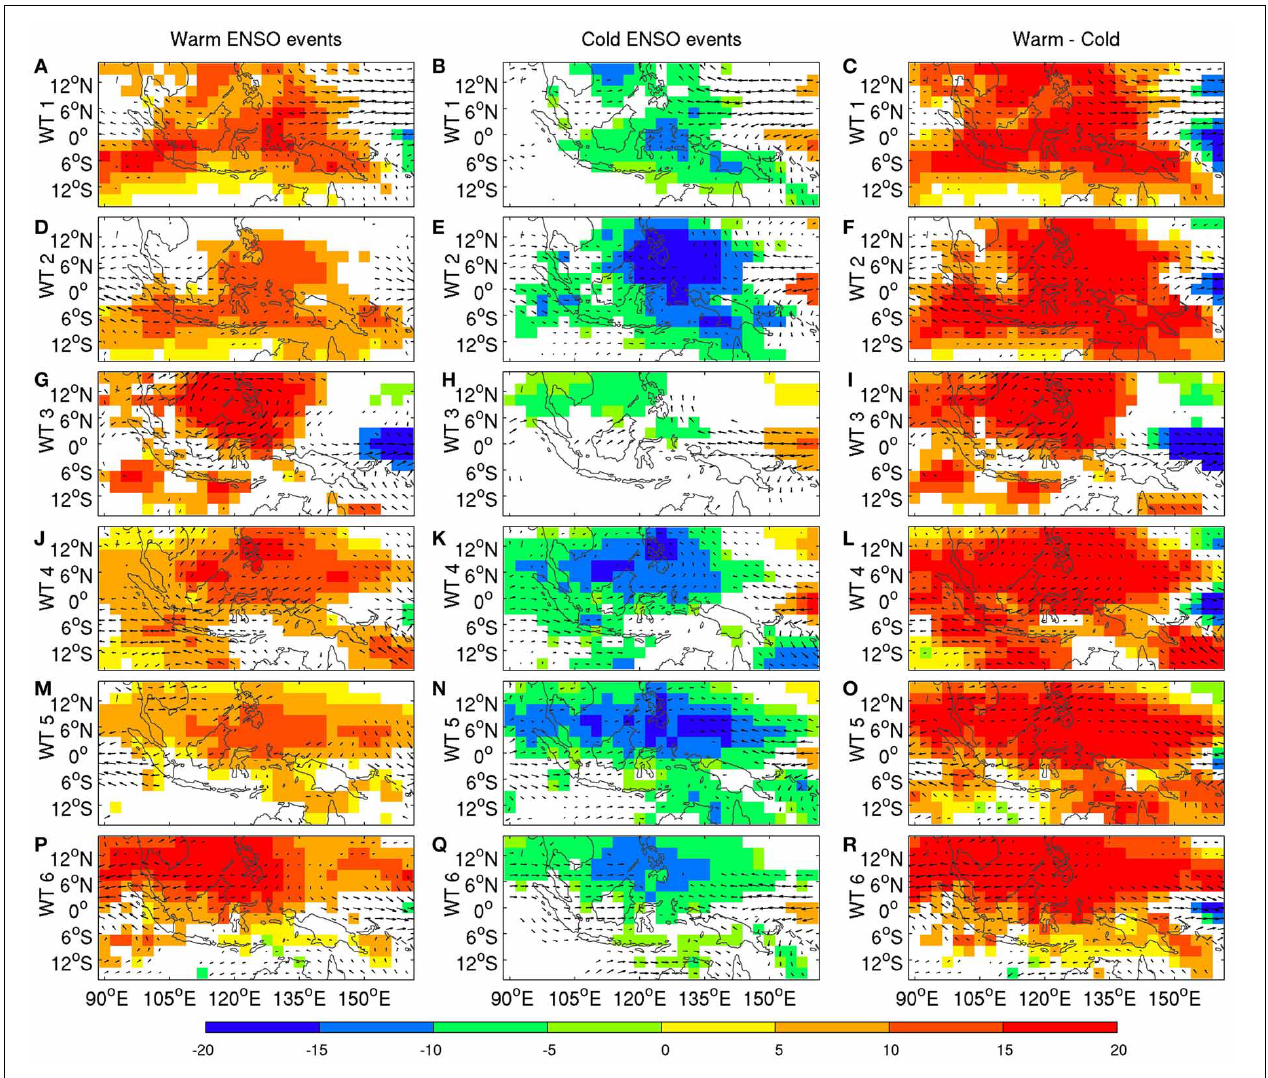
FIGURE 6 | Mean OLR (shading in Wm − 2 ) and 850-hPa wind anomalies: (left column) 10 warmest ENSO events; (middle column) 13 coldest ENSO events; and (right column) difference between warm and cold ENSO events for (A–C) WT 1, (D–F) WT 2, (G–I) WT 3, (J–L) WT 4, (M–O) WT 5, (P–R) WT 6. Warm and cold ENSO events